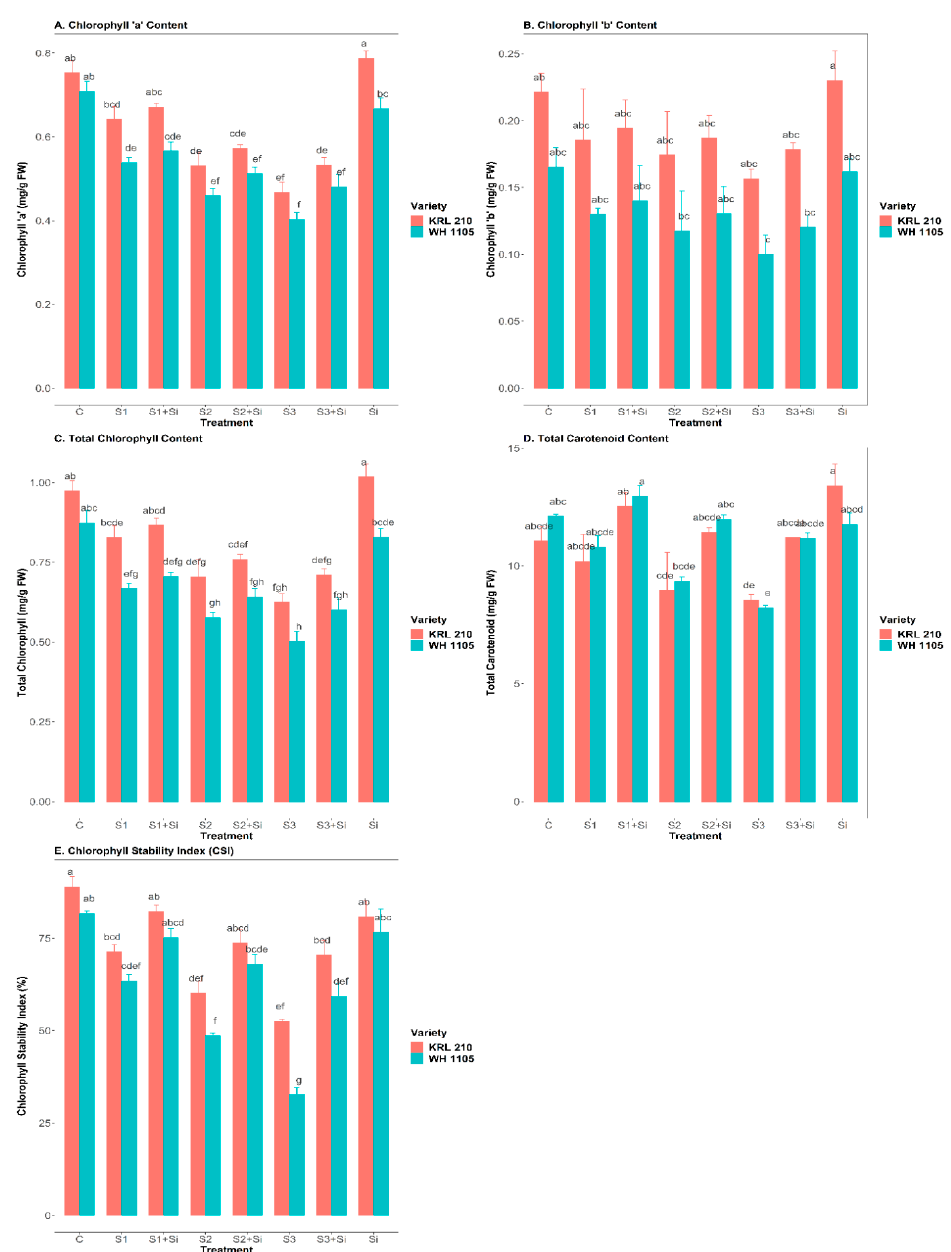
Figure 2. Effect of Si on chlorophyll ‘a’ ( A ), chlorophyll ‘b’ ( B ), total chlorophyll ( C ), carotenoid content ( D ), and CSI ( E ) in salt-stressed wheat plants. Means ± SE; Two-way ANOVA with Tukey’s post hoc test; Each bar having different alphabets was significantly different between treatments ( p < 0.05). C: Control, S1: 40 mM NaCl stress, S2: 80 mM NaCl stress, S3: 120 mM NaCl stress, Si: 2 mM Silicon.